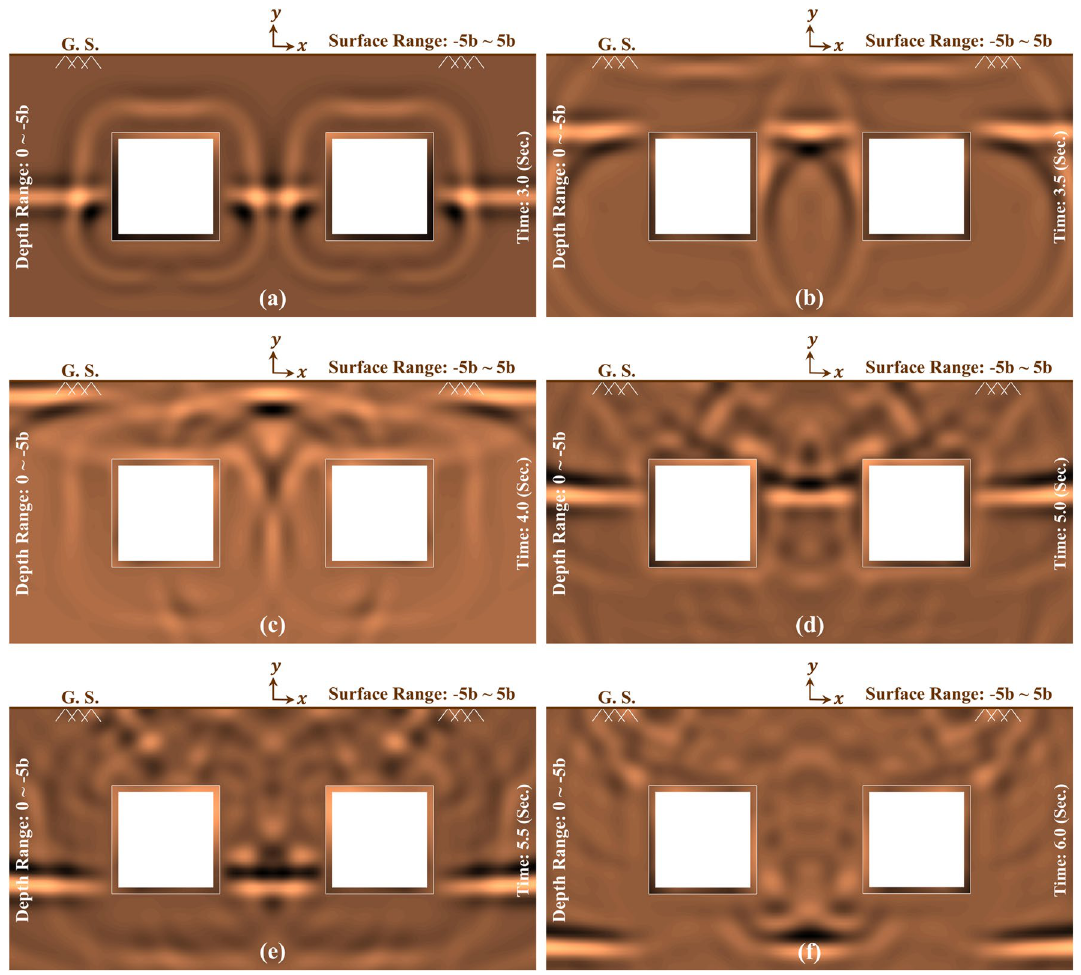
Fig. 8 Wave propagation snapshots and the procedure of the SH waves’ dispersion below the ground surface, for the model of twin square- shaped lined tunnels subjected to vertical incident